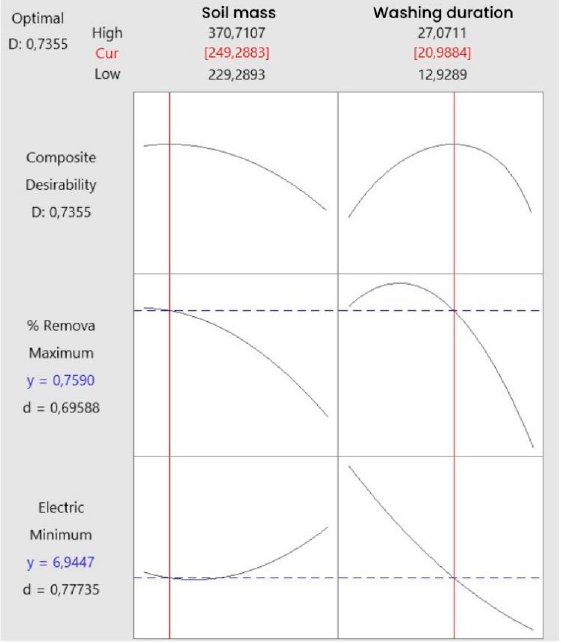
Figure 15. Multiple response prediction for simultaneous optimization of oil removal (%) and energy consumption related to the Central composite rotational design (CCRD).